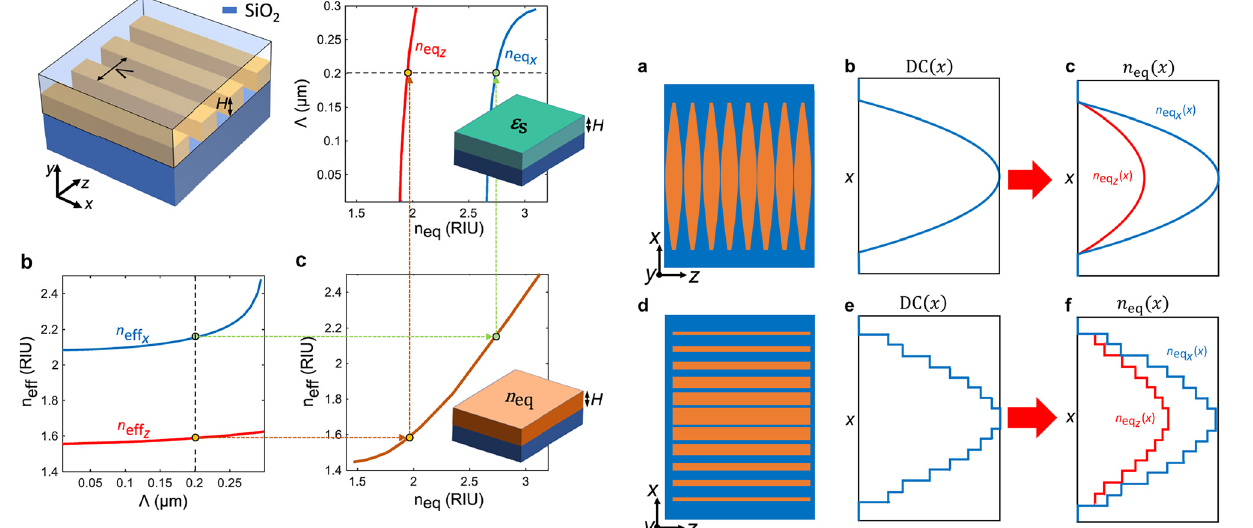
Figure 6: GRIN metamaterial waveguides with variable duty cycle ) and based on (a) longitudinal and (d) transverse SWG structures. (b), (e) x ApodizeddutycycleDC( x )ofthesubwavelengthstructuresin(a)and (d), respectively. (c), (f) Homogeneous anisotropic metamaterial tensor components n eq x ( ) and n eq x ( ) of the subwavelength x z structures of (a) and (d),